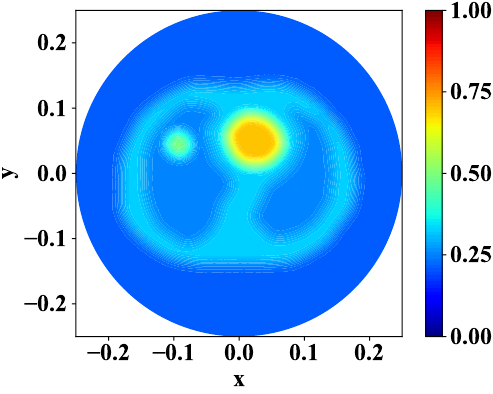
Figure 14. The true conductivity distributions of smooth–heart–lung model.